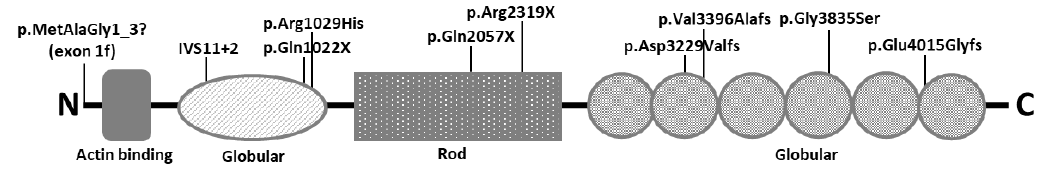
Figure 5. Location of PLEC mutations associated with myasthenic phenotypes. Most cases are compound heterozygous for null mutations located in the globular domains; the only homozygous mutation with myasthenic phenotype described so far, and in this article, is in exon 1f [21 – 24]. To the best of our knowledge, only a few cases of EBS-MD with myasthenia have been described